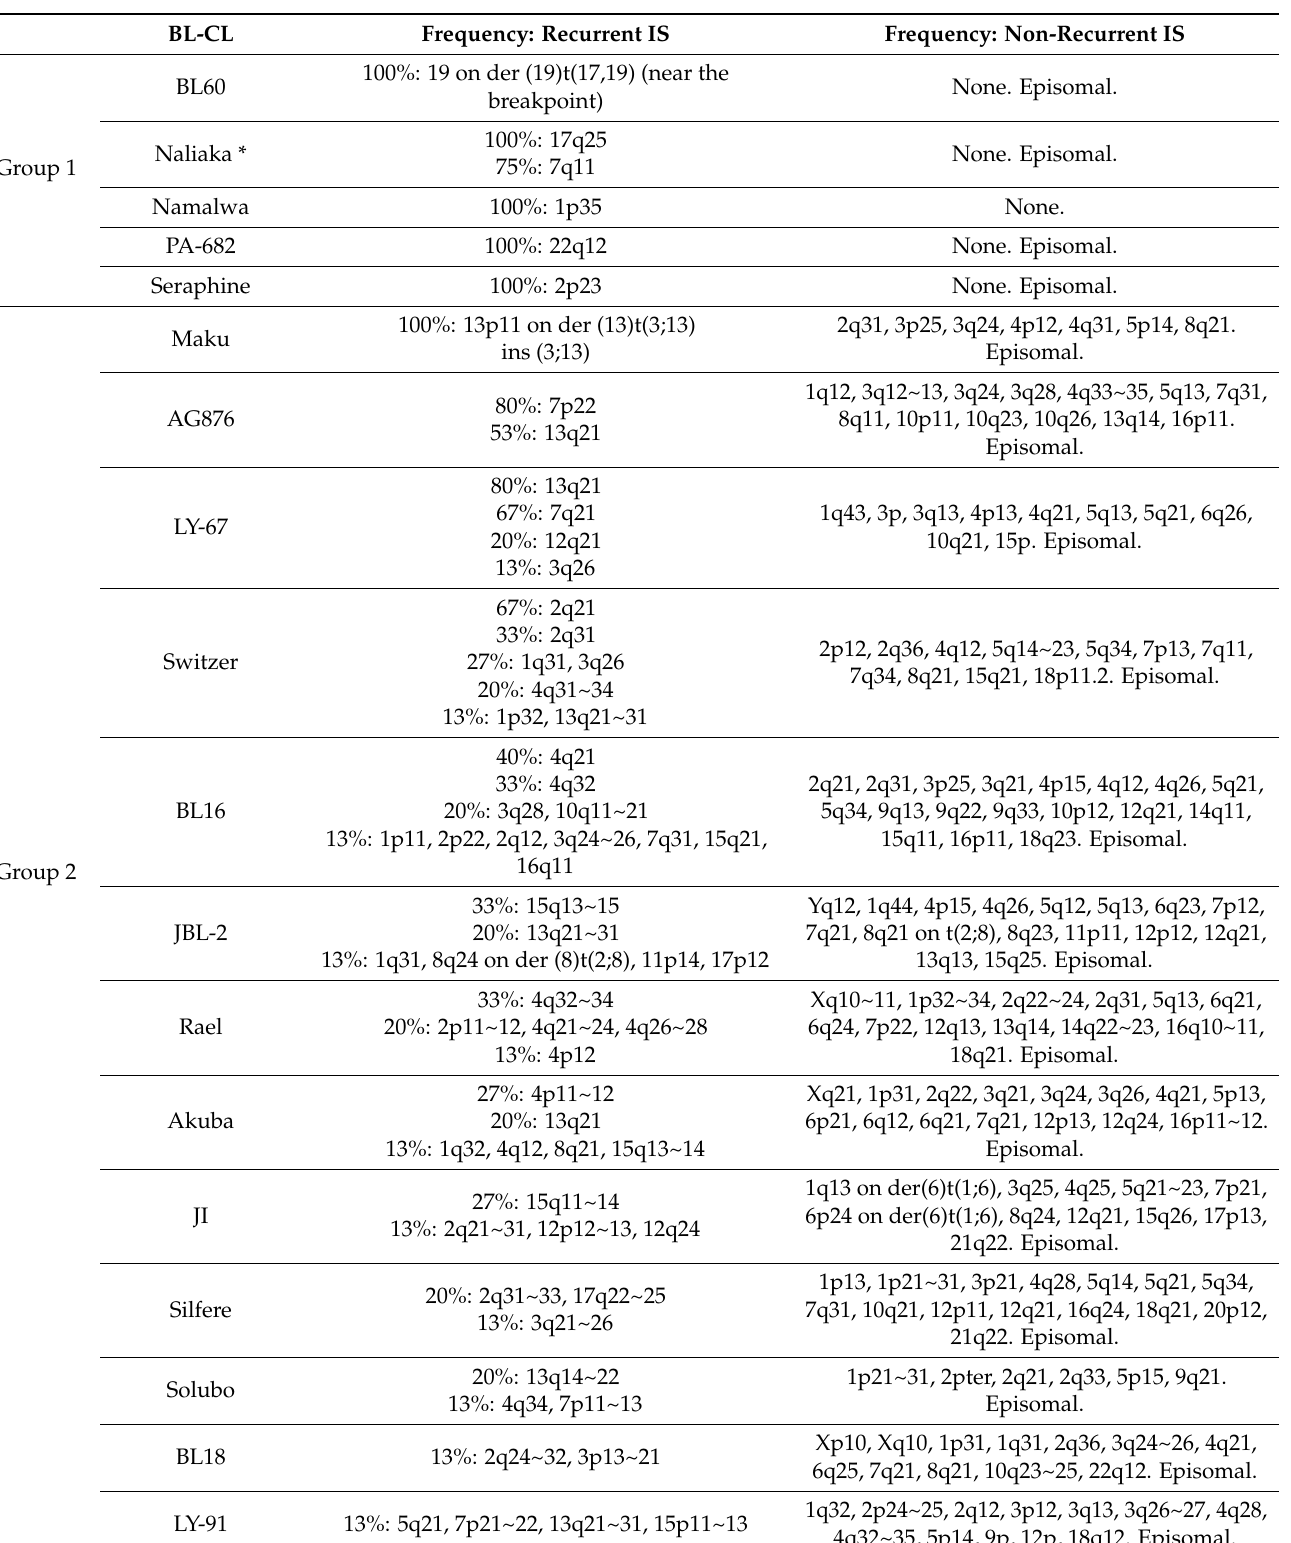
Table 2. Chromosomal distribution of the recurrent and non-recurrent EBV-IL in analyzed BL cell